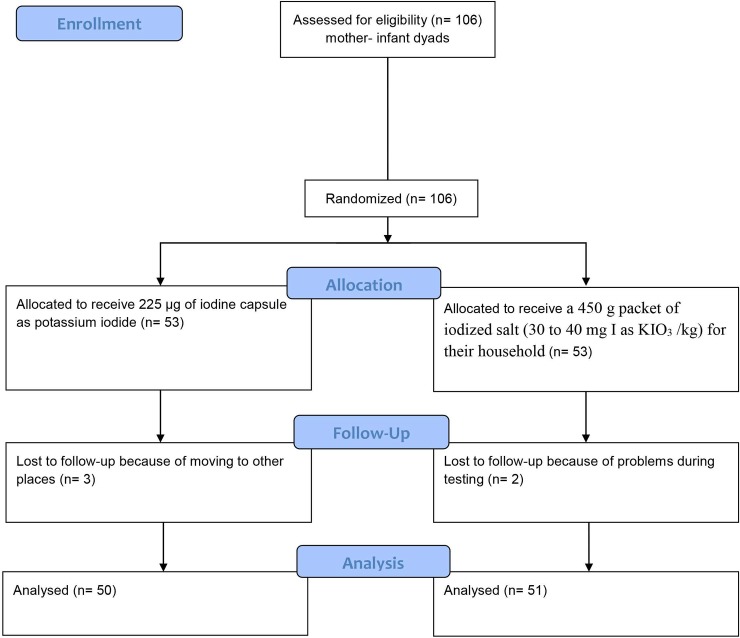
Research design.(CONSORT flow diagram).